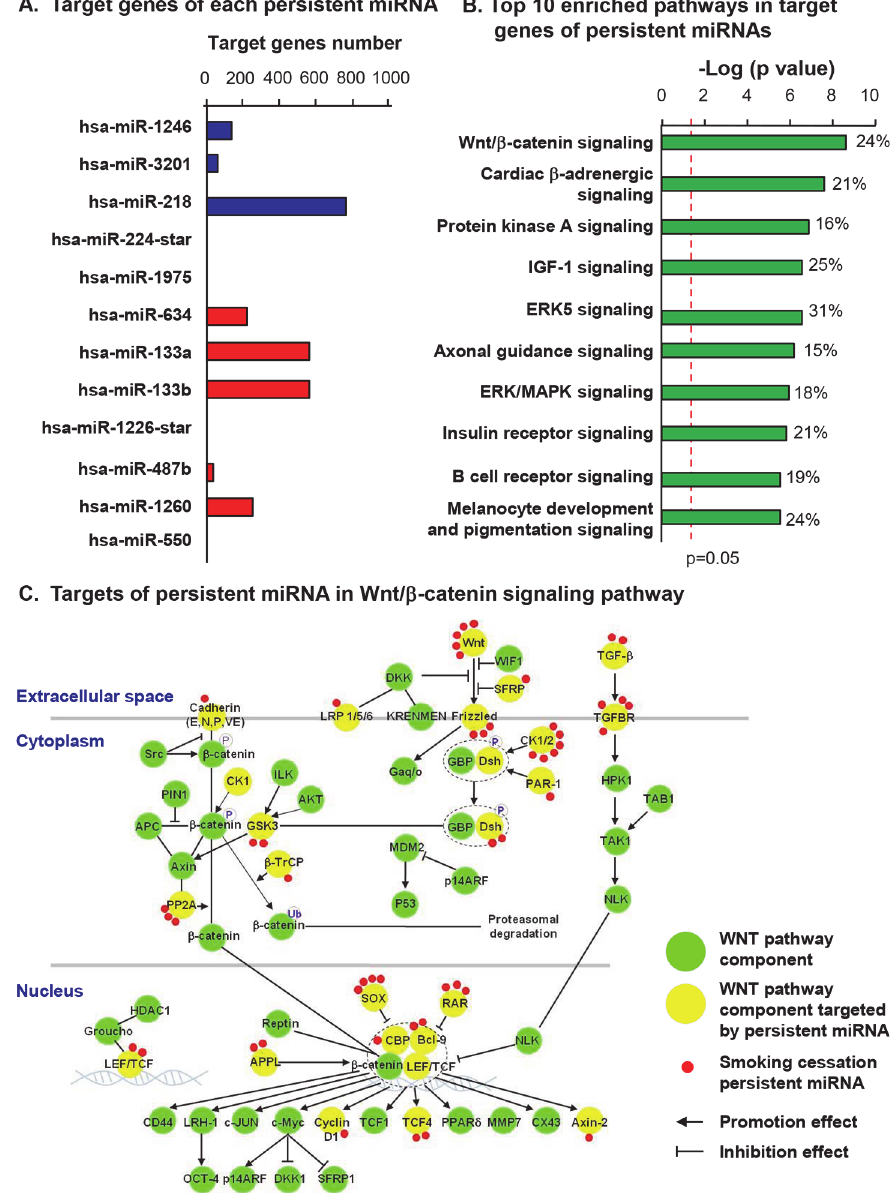
Fig 4. Target genes of smoking cessation persistently altered miRNAs in the human SAE. A: Numbers of predicted target genes for each of the persistent miRNAs. The target genes prediction was based on Target Scan 6.2 database. Only genes that are expressed in human SAE were used for the analysis. Blue, target genes of persistent-down-regulated miRNAs. Red, target genes of persistent-up-regulated miRNA. The persistently dysregulated miRNAs with the highest target gene number were miR-218 and miR-133a and miR-133b targets. B: Top 10 enriched canonical pathways in the target genes of the smoking cessation persistent miRNAs. The analysis was performed using Ingenuity Pathway Analysis software. X axis,-log of p value, Fisher's exact test. The ratio of genes that were targeted by the smoking cessation persistent-miRNA in each pathway are indicated. C: Wnt/ β -catenin signaling pathway associated with persistently dysregulated miRNAs despite smoking cessation. The Wnt pathway genes that are targets of the smoking cessation persistent miRNAs are highlighted by yellow. The correspondent miRNAs are marked red, with the number of red dots corresponding to the number of miRNAs targeted toward each gene. Many Wnt pathway ligands, receptors, effectors and regulators are potential targets of the smoking cessation persistent miRNAs. Abbreviations: IGF-1, insulin-like growth factor 1; ERK5, Extracellular signal-regulated kinase 5; MAPK, mitogen-activated protein